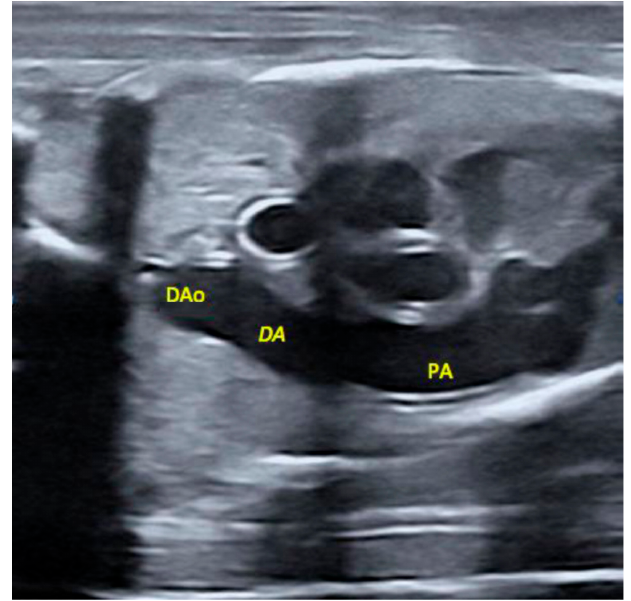
Figure 3. The image shows gray scale normal appearance of the ductus arteriosus. DAo: Descending Aorta; DA: Ductus arteriosus; PA: Pulmonary